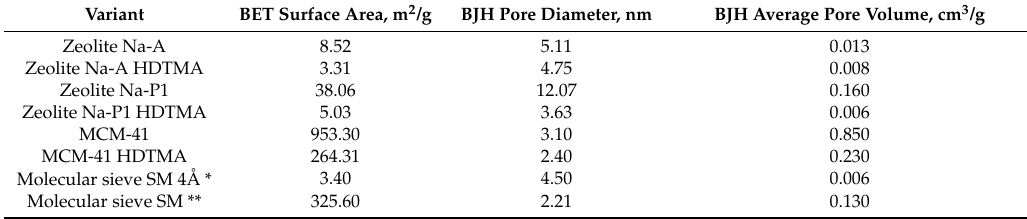
Table 1. Textural parameters of the studied zeolite and silica materials.